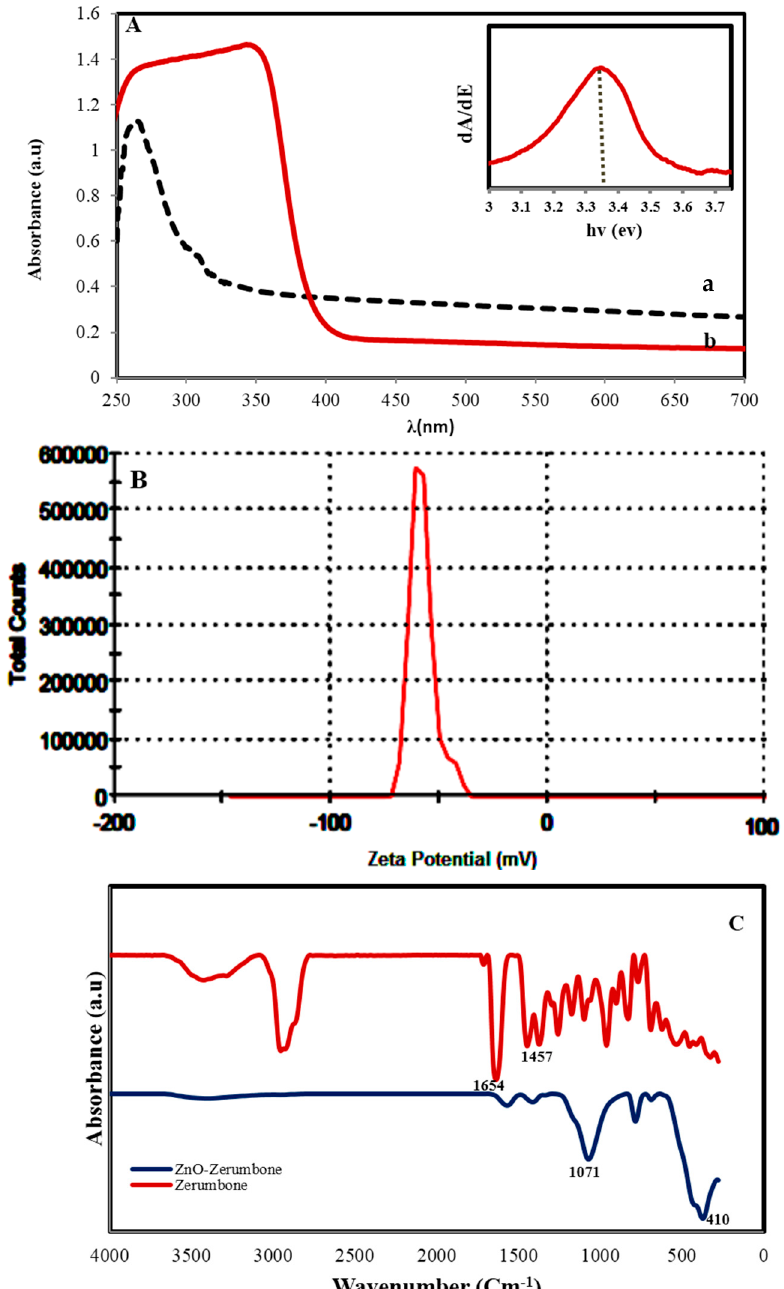
Figure 3. ( A ) UV–Vis spectrum ((a) zerumbone (b) bio-synthesized ZnO NPs, and (inset) band gap estimation) ( B ) zeta potential of ZnO NPs and ( C ) the FTIR spectrum of pure zerumbone before and